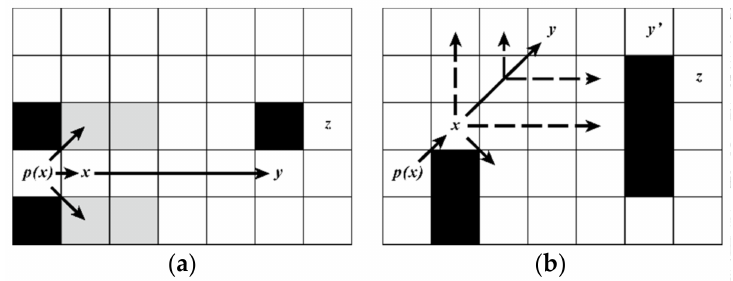
Figure 6. Examples of straight ( a ) and diagonal ( b ) jumping. Black blocks are obstacles, grey blocks are pruned nodes, the dashed arrows mean the search processes return no jump points, and the solid arrows mean finally a jump point successor is